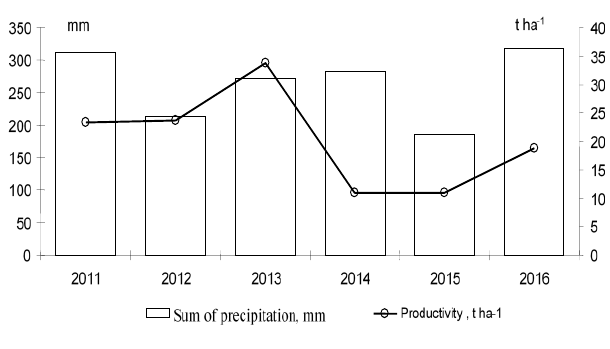
Figure 2. Productive raw material yield depending on the amount of precipitation